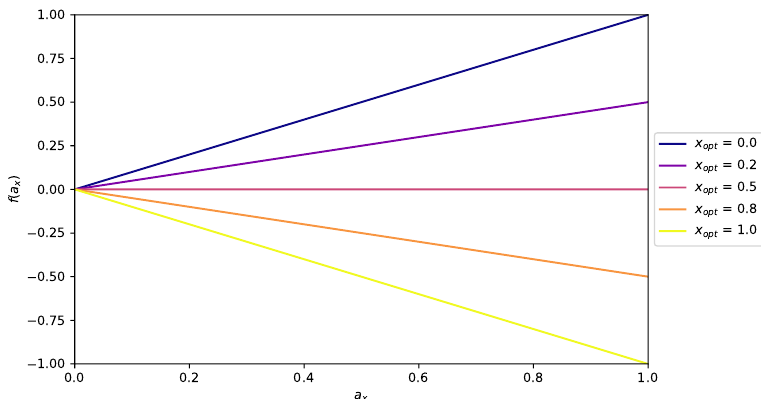
Figure 3. Plots showing different fear inductor functions for different optimal